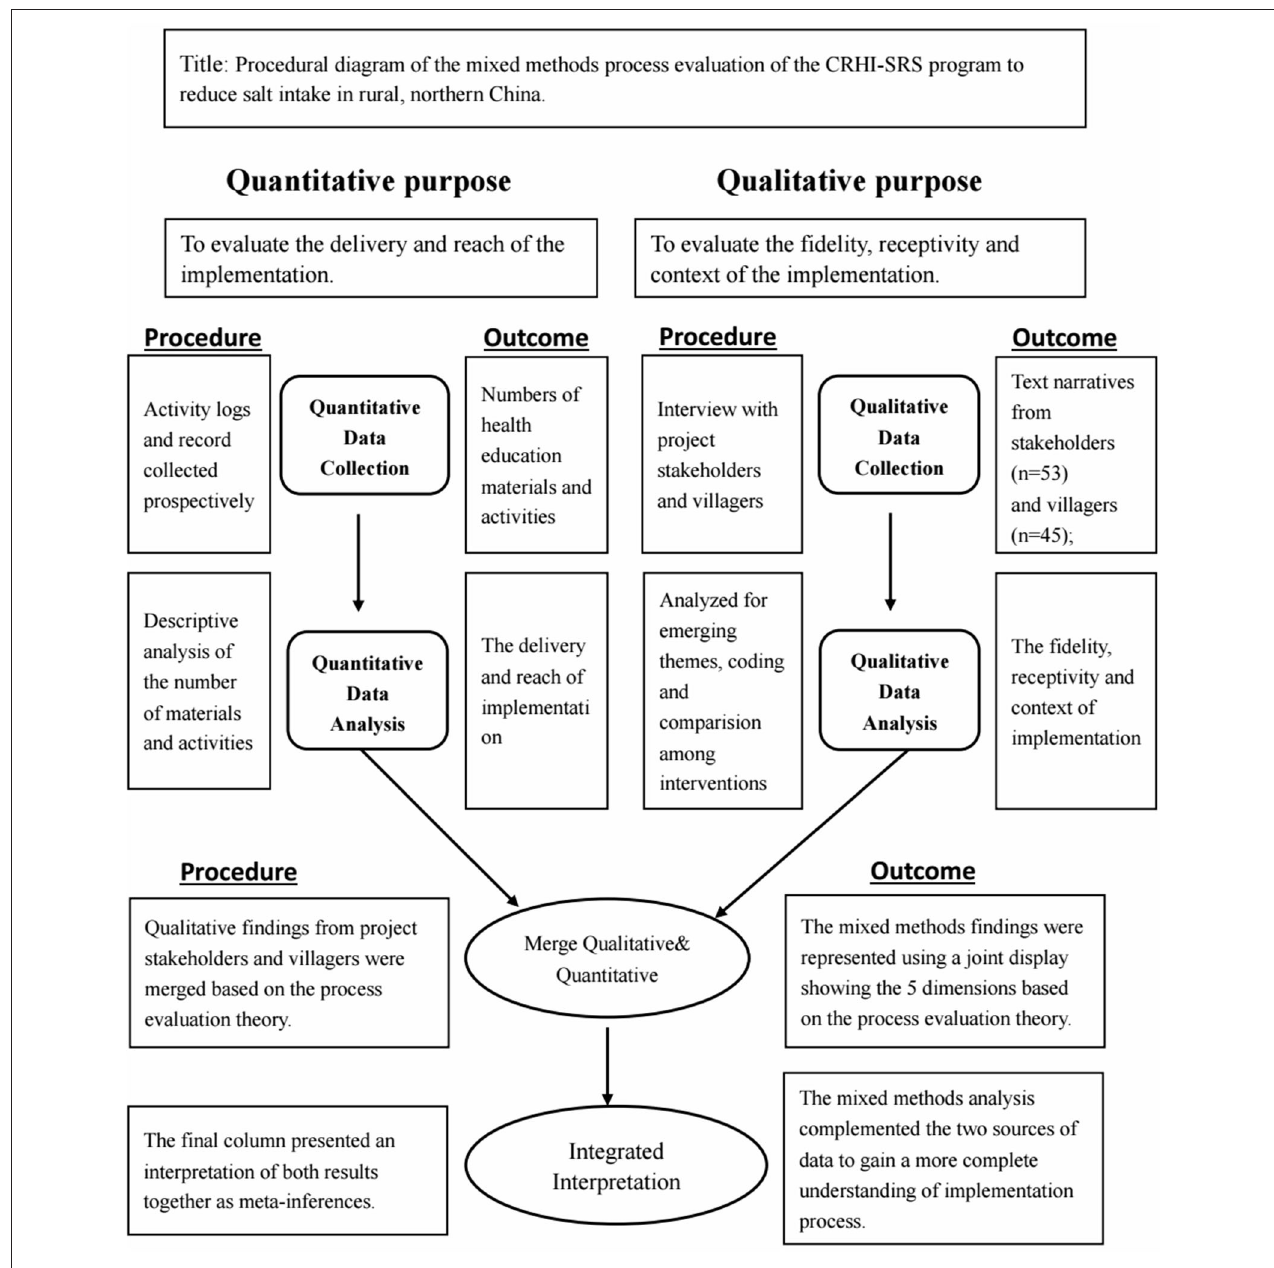
FIGURE 1 | Diagram of convergent mixed-methods process